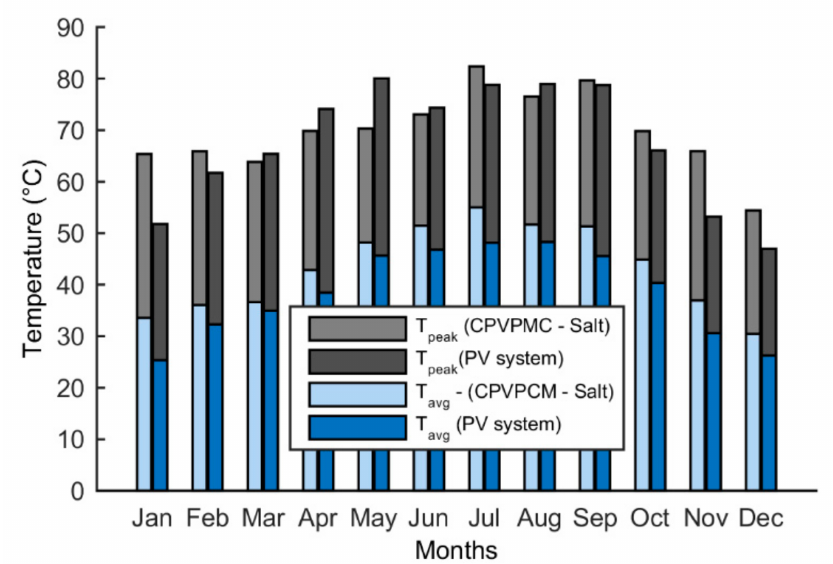
Figure 15. Comparison of peak and average temperature of both